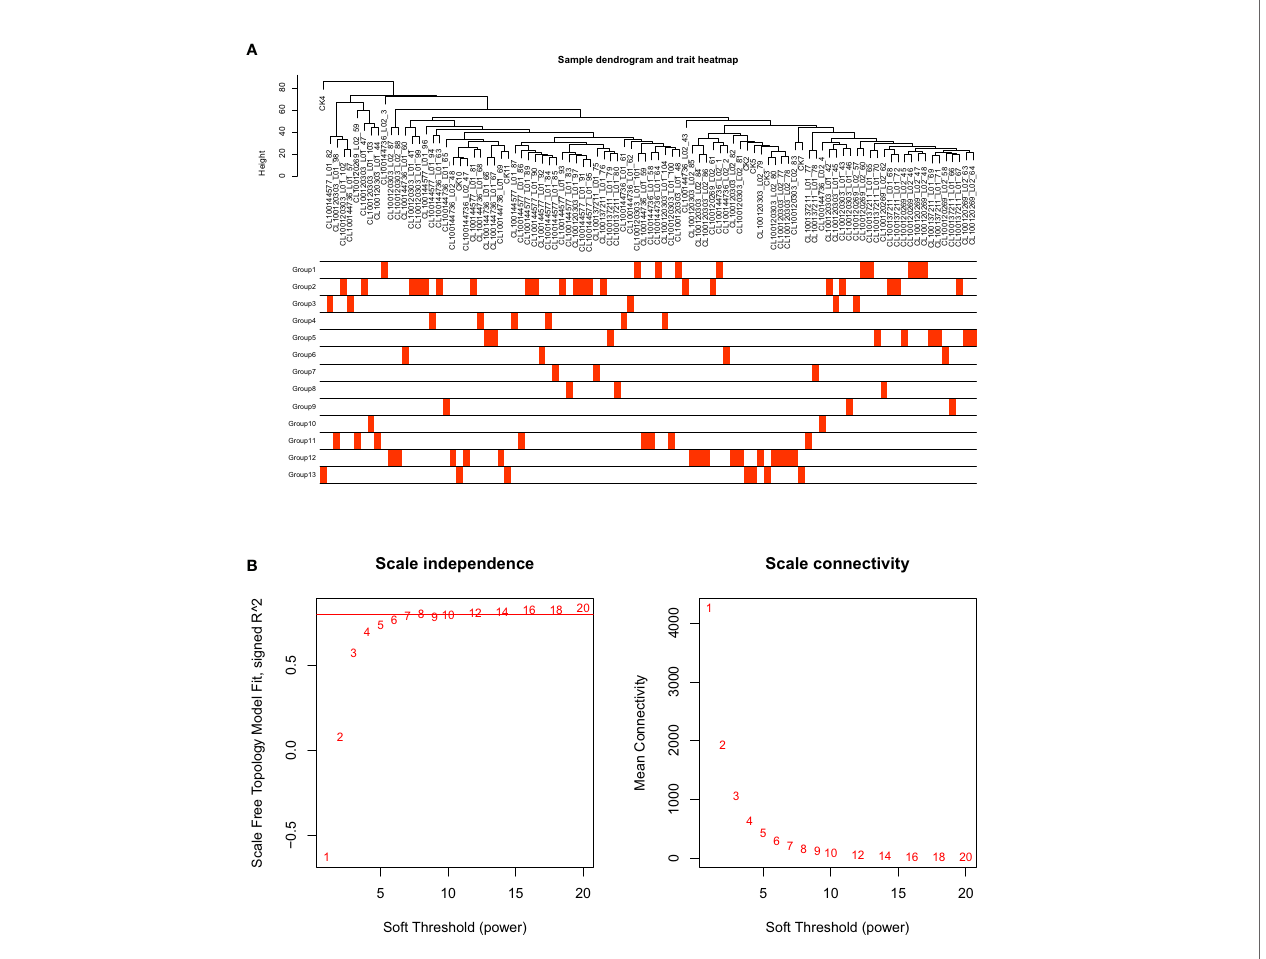
FIGURE 6 | Sample dendrogram and estimation of soft-thresholding values. (A) Sample dendrogram and trait heatmap. The cut height was set to 80. The traits of 13 groups were classi fi ed according to their pharmaceutical effect. Group 12 represents the positive control and group 13 represents the negative control. (B) Scale independence and mean connectivity of various soft-thresholding values ( b ), power of b = 11 (scale free R2 =